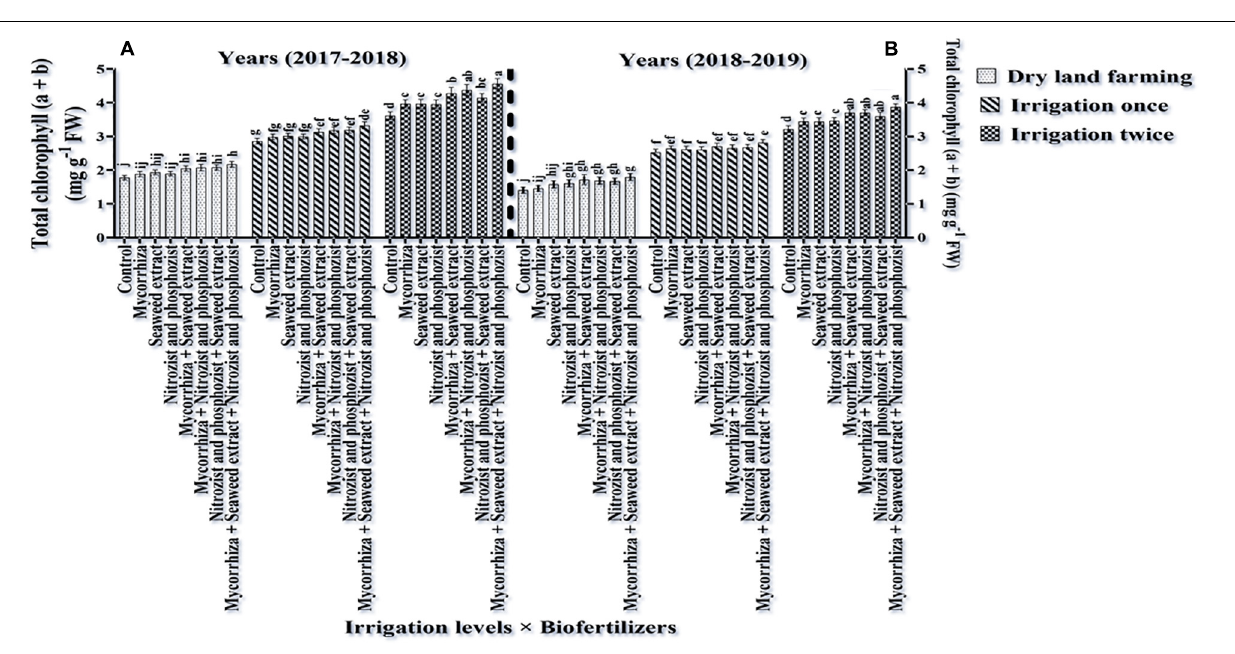
water absorption and retention. The role of hyphae